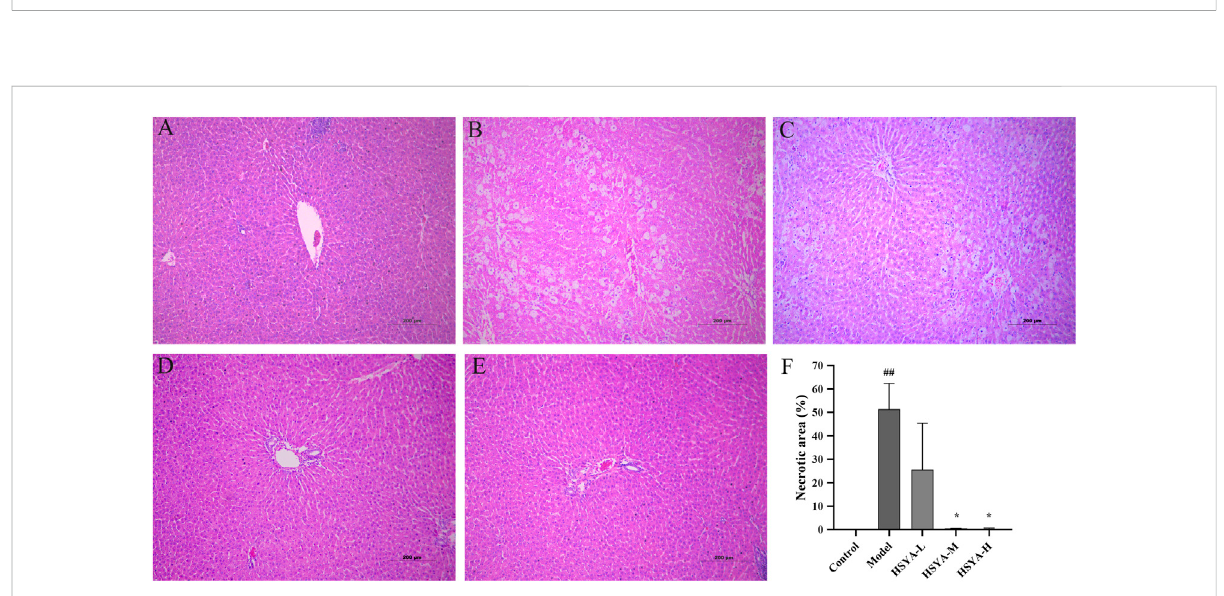
rats were slightly disordered, it was easy to see the structure of liver lobules, the liver cells were accompanied by mild edema and steatosis, apoptotic bodies were occasionally seen around the central vein, the in fl ammatory in fi ltration was signi fi cantly reduced, and the pathological manifestations of liver tissues tended to be normal (Figure 5E). The